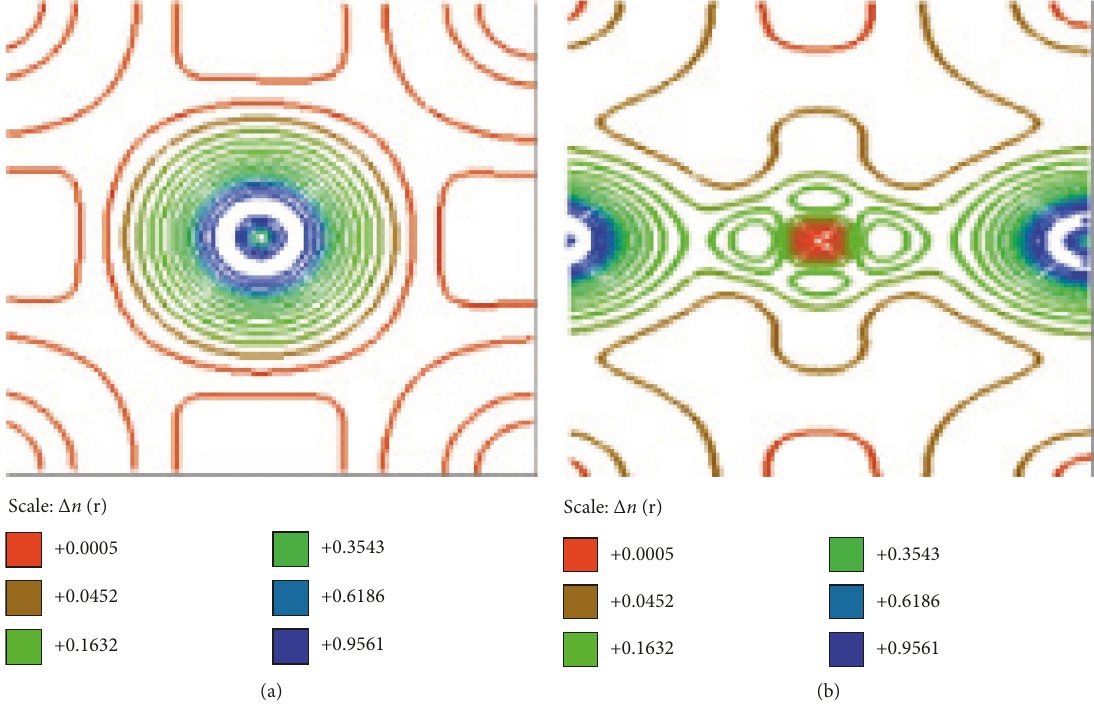
Figure 8: Electronic charge density in 100 and 110 plane of SnTiO